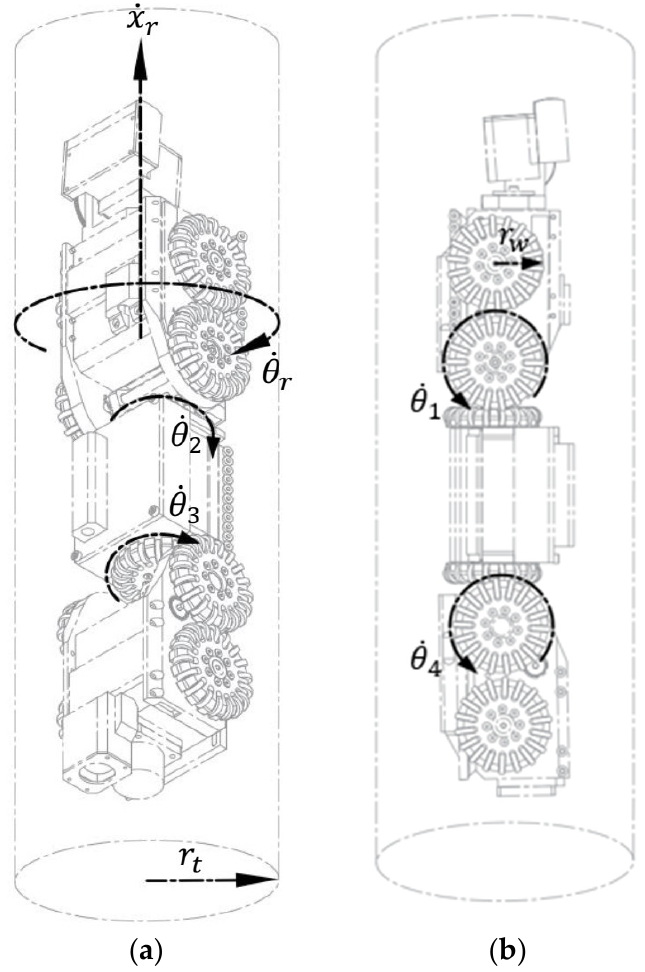
Figure 9. A kinematic model of the in-pipe robot with ( a ) perspective view and ( b ) side view.